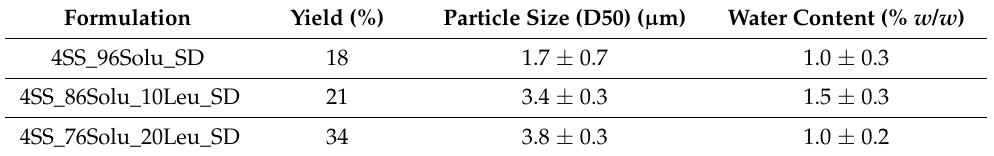
Table 2. The spraying drying process yield, water content, and particle size of the various formula- tions (4% salbutamol/96% soluplus (4SS_96Solu_SD), 4% salbutamol/86% soluplus/10% leucine (4SS_86Solu_10Leu_SD), and 4% salbutamol/76% soluplus/20% leucine